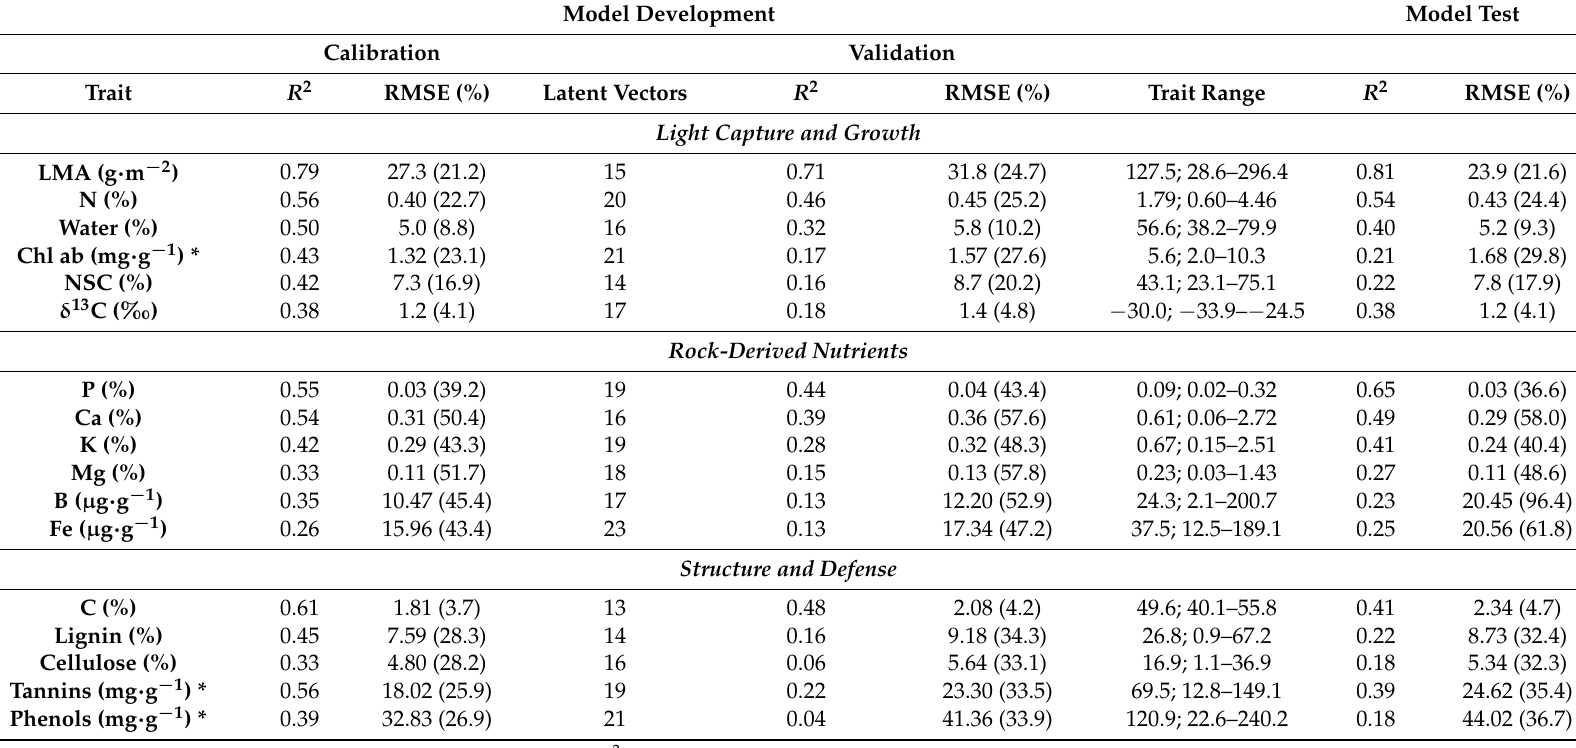
RMSE: root mean square error in units of the original chemical assays. R 2 : regression coefficient. Latent Vectors: number of spectral weighting vectors, or orthogonal degrees of freedom, from the VSWIR data used for the chemical determination. * indicates chemical traits measured from flash frozen samples. These were only available from a subset of sites (Danum Valley, Kinabatangan, and Sepilok). For these traits, the number of crowns used in model generation and testing were 126 and 57